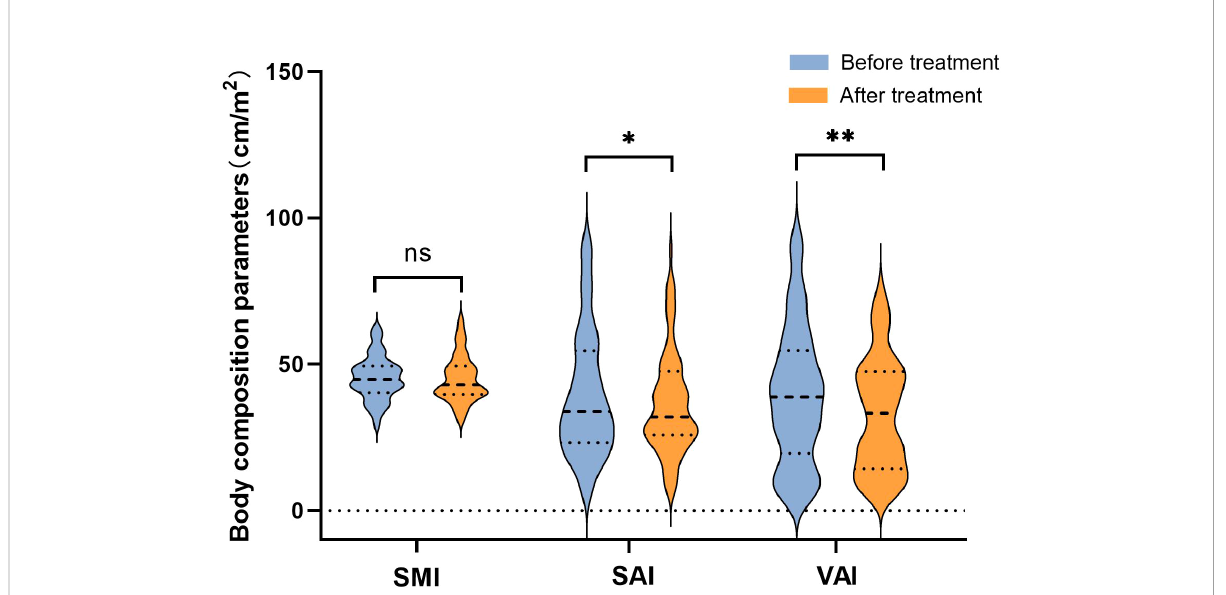
FIGURE 3 Changes of body composition parameters before and after neoadjuvant immunotherapy. “ * ” means p < 0.05; "**" means p < 0.01.